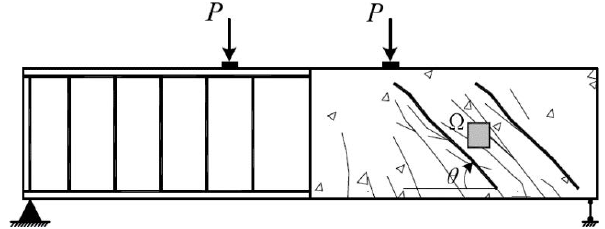
Fig. 1 RC beam with diagonal cracks. RC , reinforced concrete